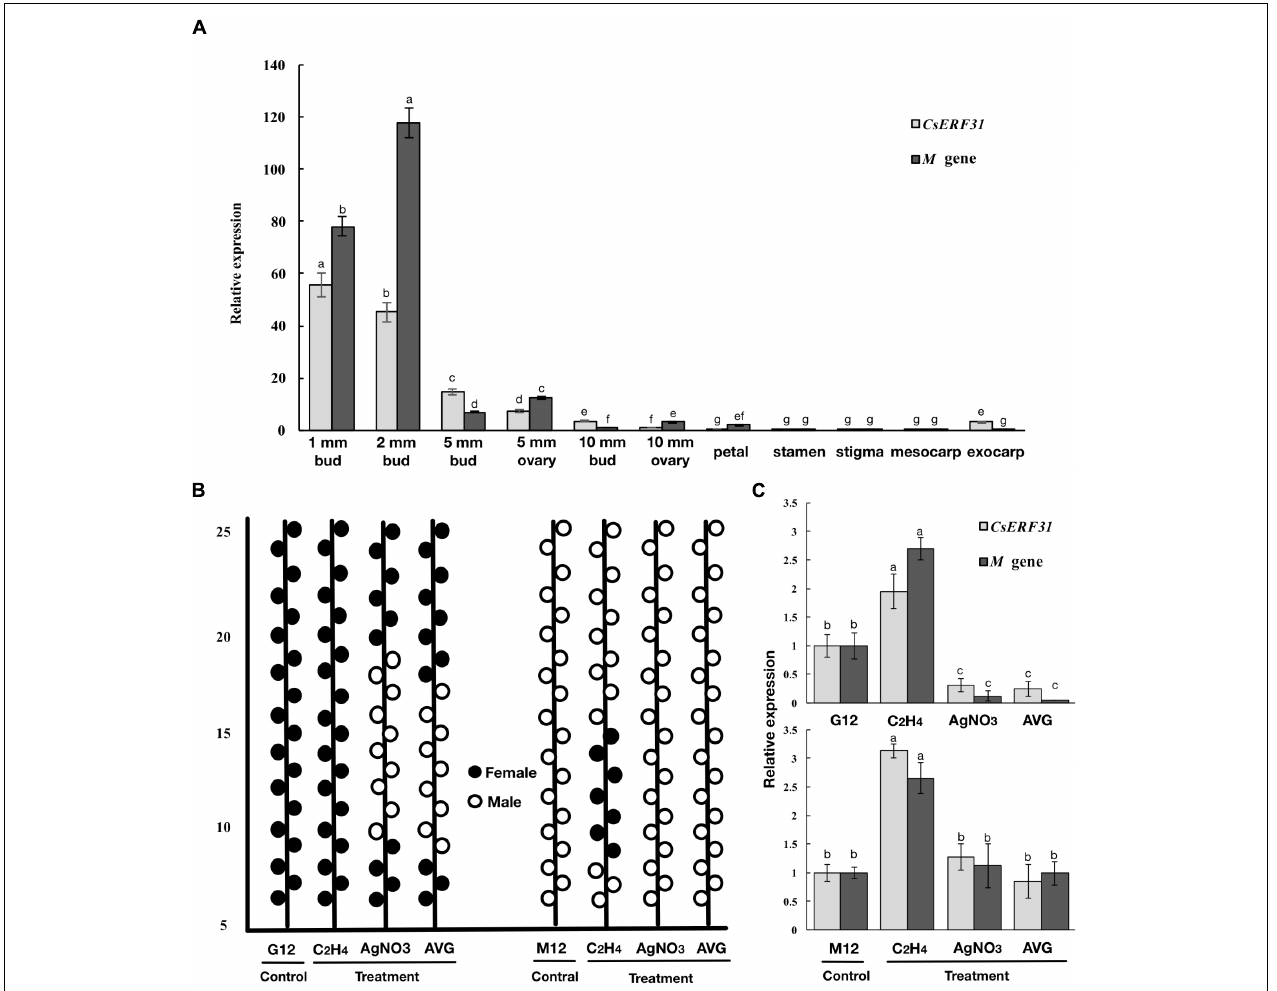
FIGURE 4 | Expression patterns of M and CsERF31 in flower organs and shoot apices treated by ethylene-related chemical. (A) Temporal expression patterns of M and CsERF31 at different stages of female bud (1, 2, 5, and 10-mm buds were divided into 5-mm bud, 5-mm ovary, 10-mm bud, and 10-mm ovary, respectively) and spatial expression patterns of petal, stamen, stigma, mesocarp, and exocarp in the female flower before antheses according to qRT-PCR. Error bars represent the SD from three biological replicates. Different letters (a–g) indicate significant differences ( P < 0.05) of CsERF31 and M in different flower organs. (B) Schematic diagram of sex expression of the flowers from the 5th to 25th nodes at the main stems in G12 and M12 treated with ethylene-related chemical (C 2 H 4 , ethephon; AVG, aminoethoxyvinyl glycine; AgNO 3 ) and deionized water (Control), respectively. The statistical data of sexual types with the five biological replicates are shown in Supplementary Figure S2 . The flowers observed in lateral branches were not recorded. (C) Expression patterns of M and CsERF31 in shoot apices of the chemical treatments and control lines. Error bars represent the SD from the five biological replicates, and different letters (a–c) indicate significant differences ( P < 0.05) of CsERF31 and M in different